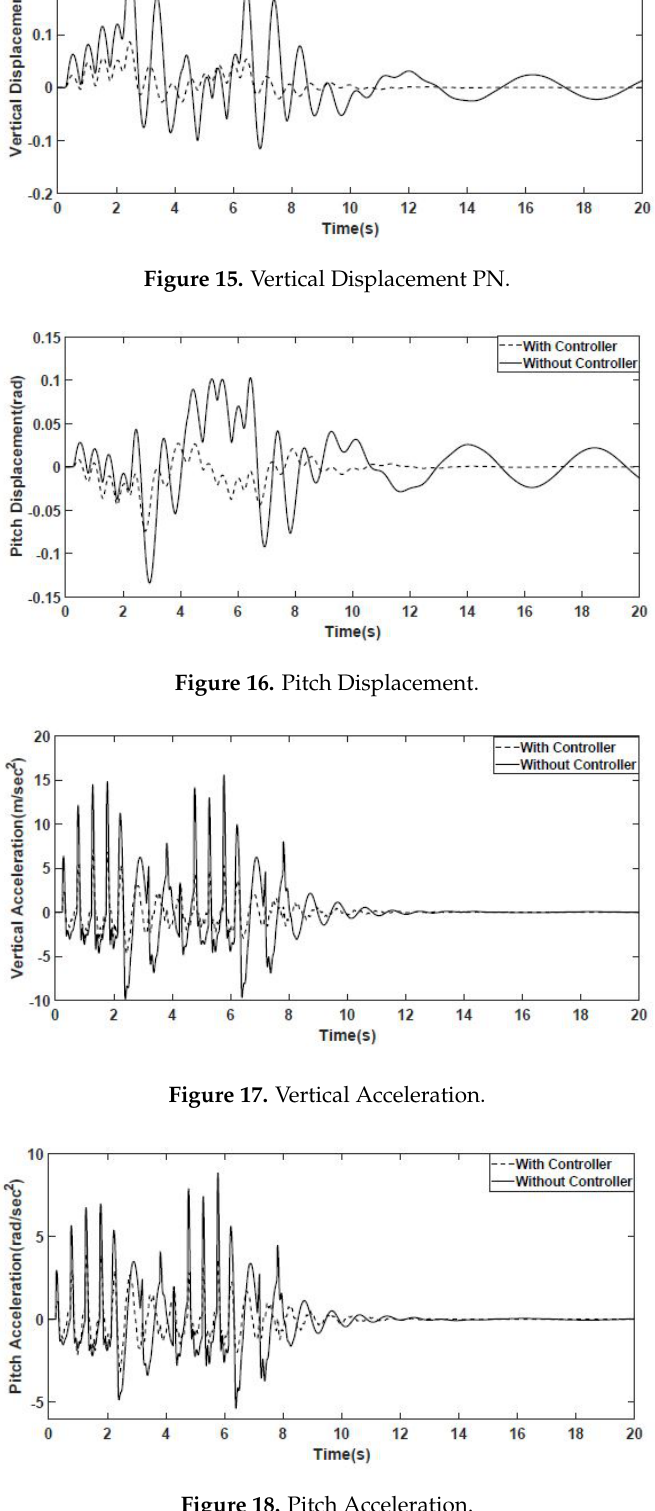
Figure 18. Pitch